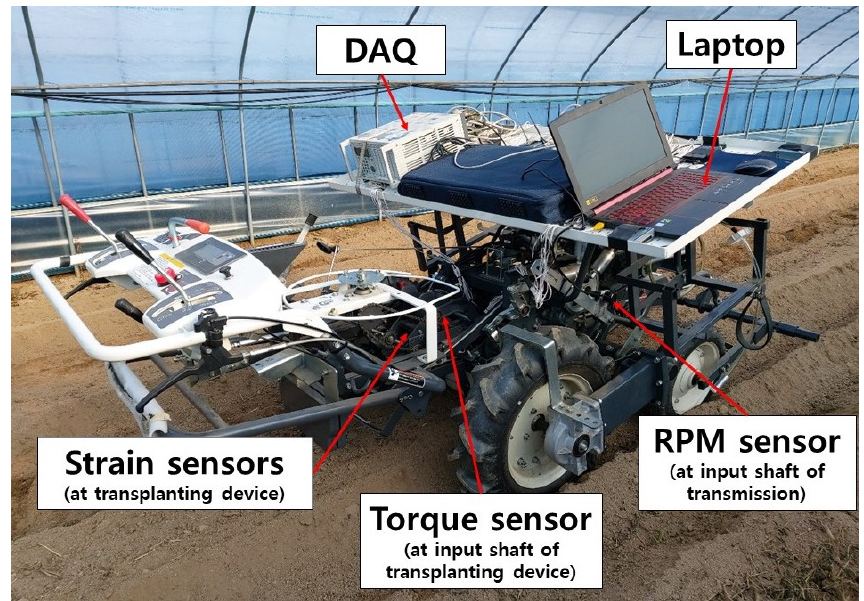
Figure 4. Measurement system for the cam vegetable transplanter.